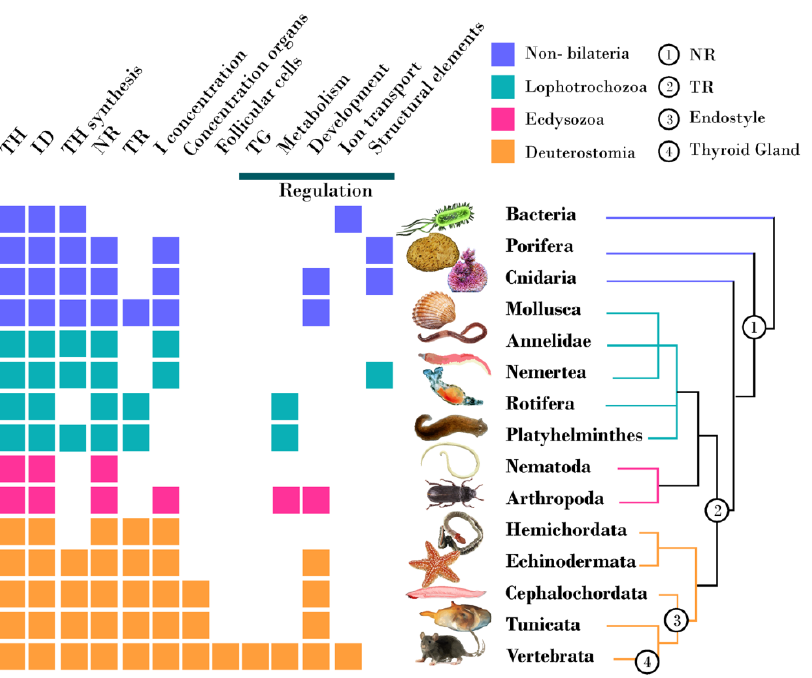
Figure 4. Components of the thyroid system in prokaryotes and eukaryotes Reprinted from Molecular and Cellular Endocrinology, 459, Taylor and Heyland, Evolution of thyroid hormone signaling in animals: Non-genomic and genomic modes of action, Pages 14-20, Copyright (2022), with permission from Elsevier. The presence of a component in a clade does not denote the occurrence in all its species. Abbreviations: I, iodine; ID, iodothyronine deiodinase; NR, nuclear receptors; TG, thyroglobulin; TH, thyroid hormones; TR, thyroid hormone receptors.